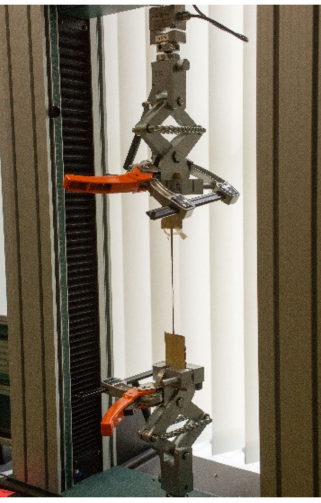
Figure 4. Set-up for the basalt fiber anchorage length and tensile strength